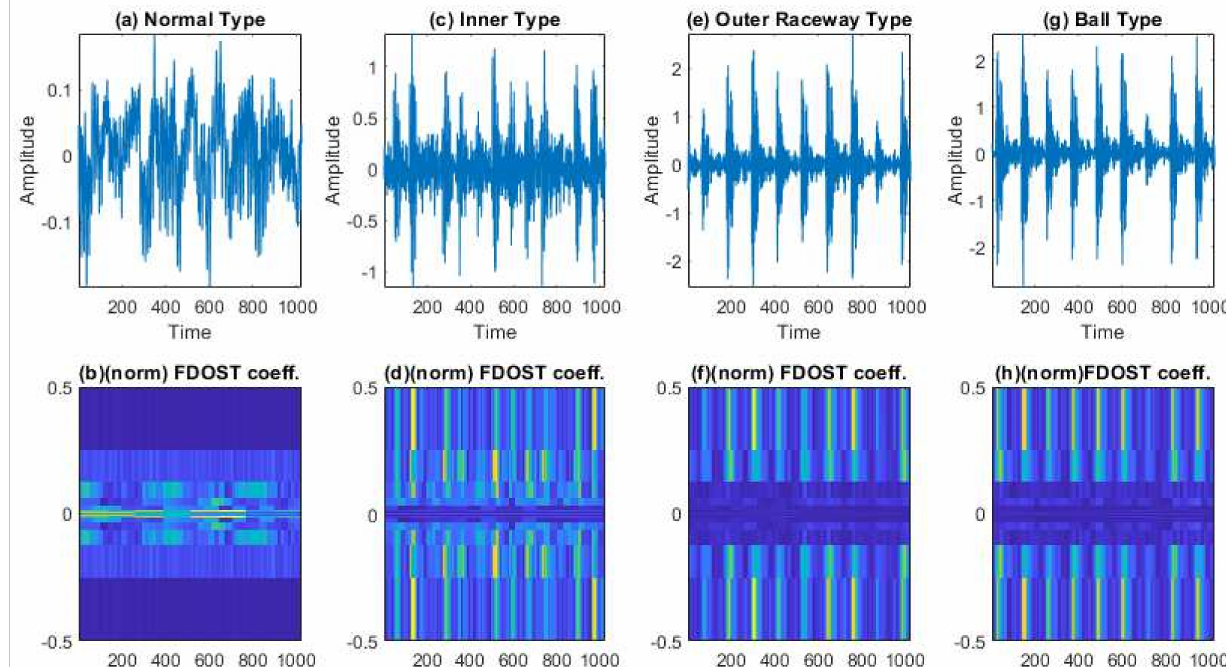
Figure 10. The visualization of dataset 3 in terms of raw time domain signals and respective 2D FDOST coefficient matrix— ( a , b ): time domain, and 2D FDOST coefficient of NT, ( c , d ): time domain, and 2D FDOST coefficient of IRT, ( e , f ): time domain, and 2D FDOST coefficient of ORT, and ( g , h ): time domain, and 2D FDOST coefficient of